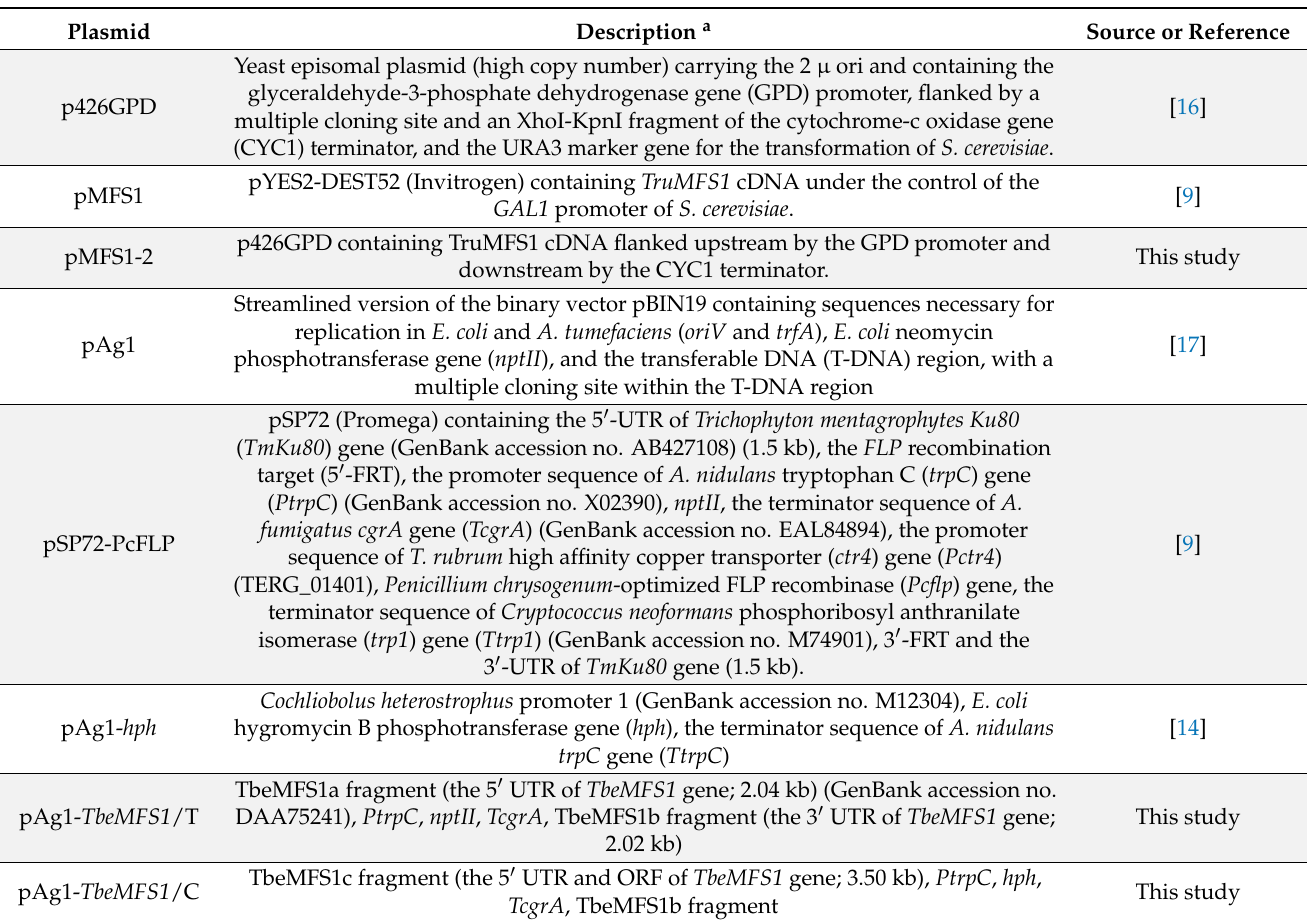
Table 1. Plasmids used in this